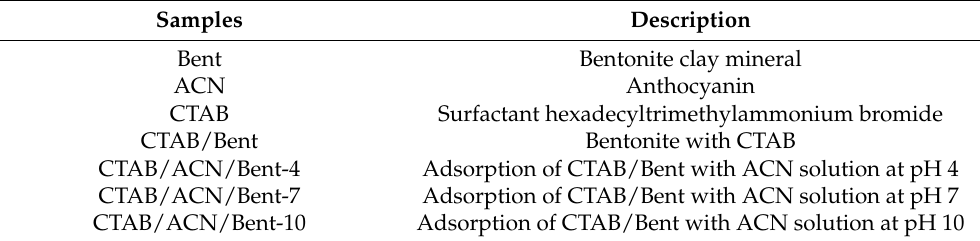
Table 4. Summary of acronyms used in the synthesized